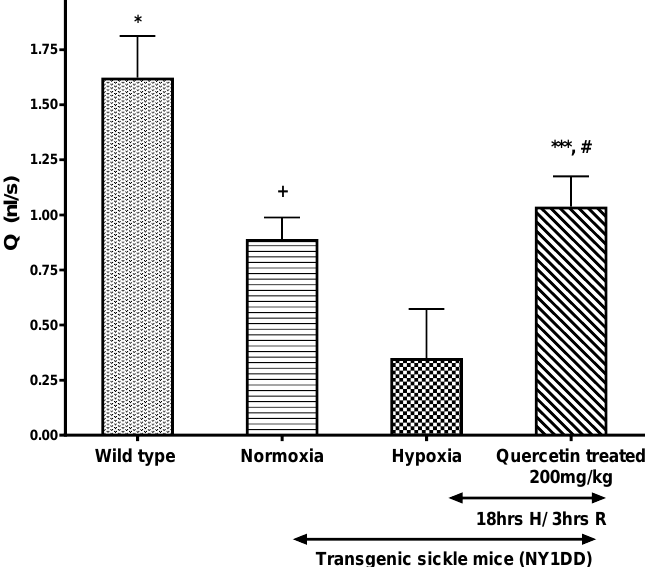
Figure 5. The effect of a single dose of quercetin (200 mg/kg, i.p.) on volumetric flow rate (Q) in wild type and NY1DD transgenic sickle mice under normoxia and hypoxia conditions. Values represent the mean ± SEM for four animals in each group; + p < 0.02 vs. normoxic wild type controls; * p < 0.0001 as compared to H/R-induced NY1DD mice; # non- significant vs. normoxic NY1DD mice; *** p < 0.0001 vs. NY1DD mice subjected to H/R